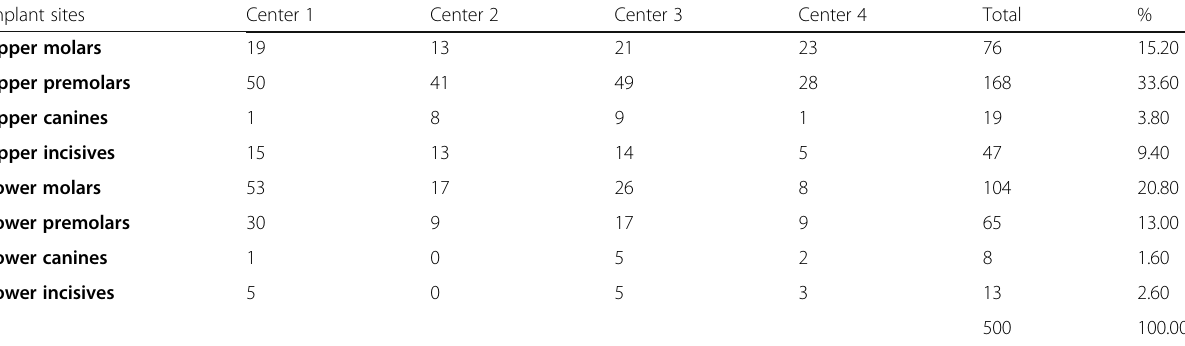
Table 2 Distribution of implant sites